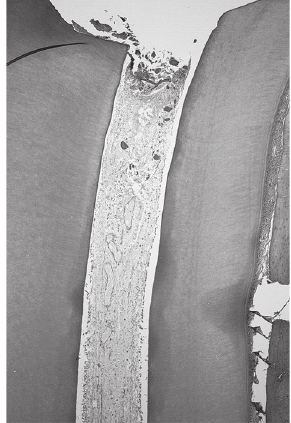
Figure 4. Group II (collagen/hydroxyapatite). Absence of dentine bridge and degenerated pulp tissue. HE; magnification X24.